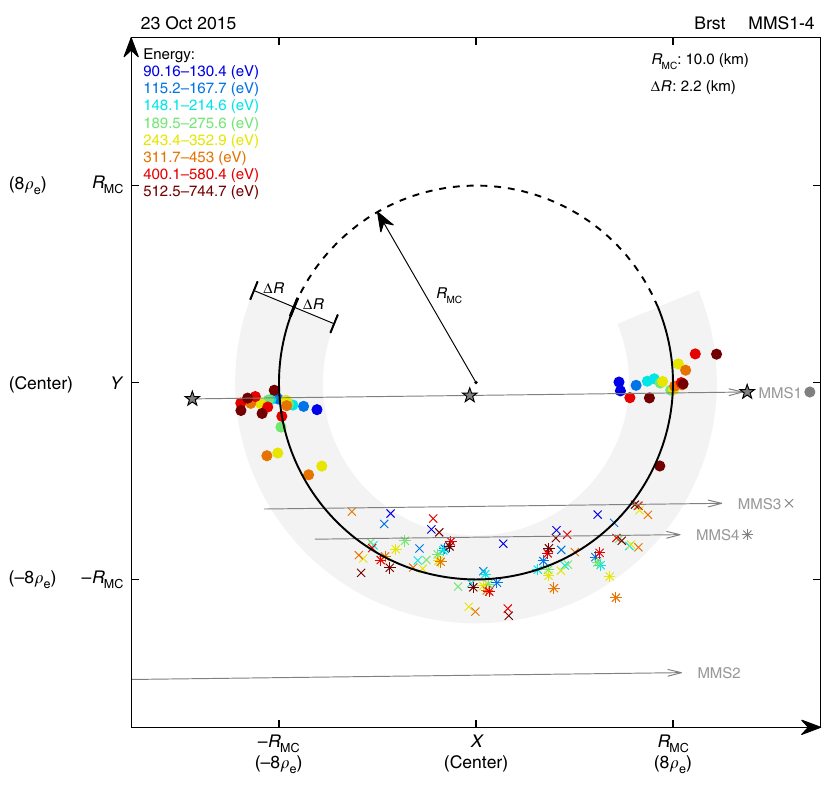
Fig. 3 Geometry of the electron scale magnetic cavity obtained by sounding technique. All data are re-organized in XY plane of the plasma rest frame. Solid circles, crosses, and asterisks represent MMS1, MMS3, and MMS4, respectively. Different colors denote different energy channels, labeled in the top left corner. A circle ( R MC , ∼ 8 ρ e ) that best fi ts the data points was obtained. The solid part of the circumference is surrounded by data, where a light gray region illustrates the uncertainty ( Δ R ). The radius and the uncertainty are labeled in the top right corner. Spacecraft trajectories are plotted as gray arrowed lines. ρ e is the gyro-radius of a thermal electron in the event discussed in this